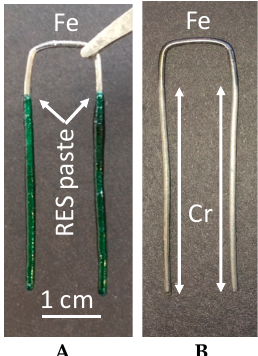
Figure 1. Macroscopic Chrome Coat on Sample I. ( A ) The iron wire sample dipped in the chrome oxide + urea + water paste. ( B ) Same wire after drying, baking for 600 s at 800 C in flowing nitrogen and vigorous hand polishing. The brightly colored area, chrome, in (B) roughly corresponds to the original paste coated section (A). The heat treatment darkens the area not under paste. Despite darkening by heat treatment, the Energy Disparsive X-ray Spectroscopy (EDAX) analysis shows no chemical change. The pure iron/uncoated section above the interface yields a pure iron